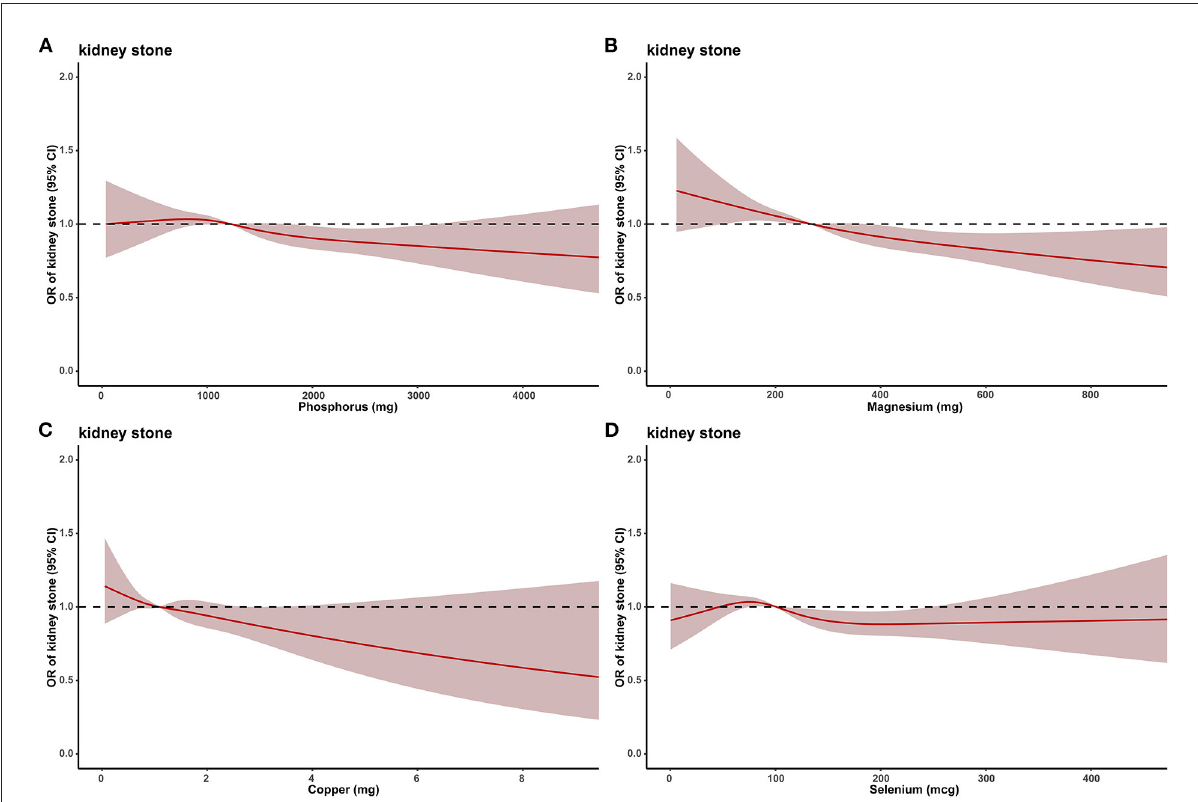
FIGURE2 The dose–response analysis between dietary metal intake and presence of kidney stones before propensity score matching. (A) Phosphorus. (B) Magnesium. (C) Copper. (D)